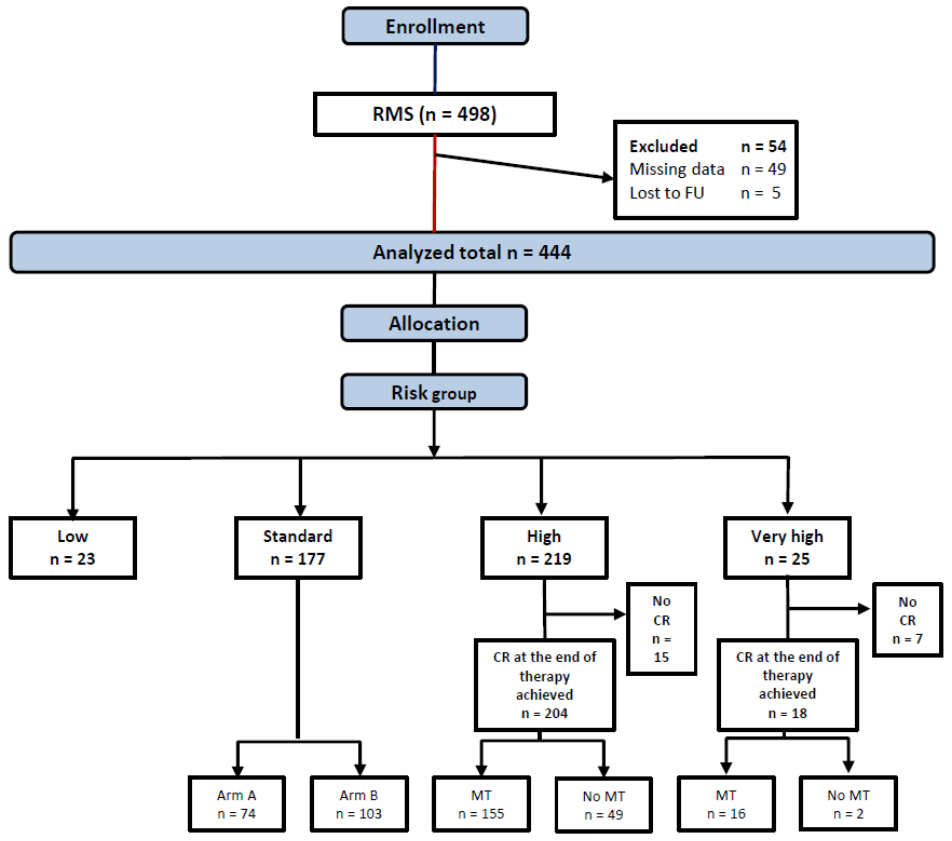
Figure 2. Consort diagram.